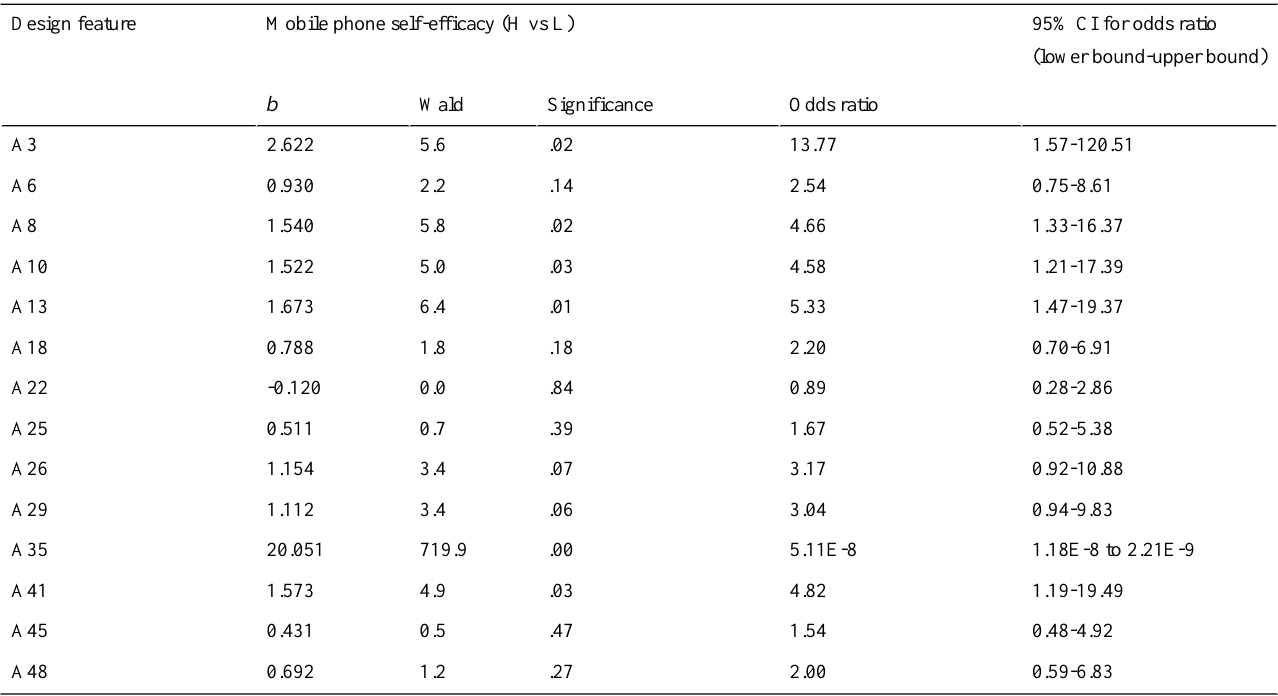
Table 15. Parameter estimates of change of mobile phone self-efficacy (MPSE) from medium to high ( valued [ attractive+one-dimensional ] over indifferent ).